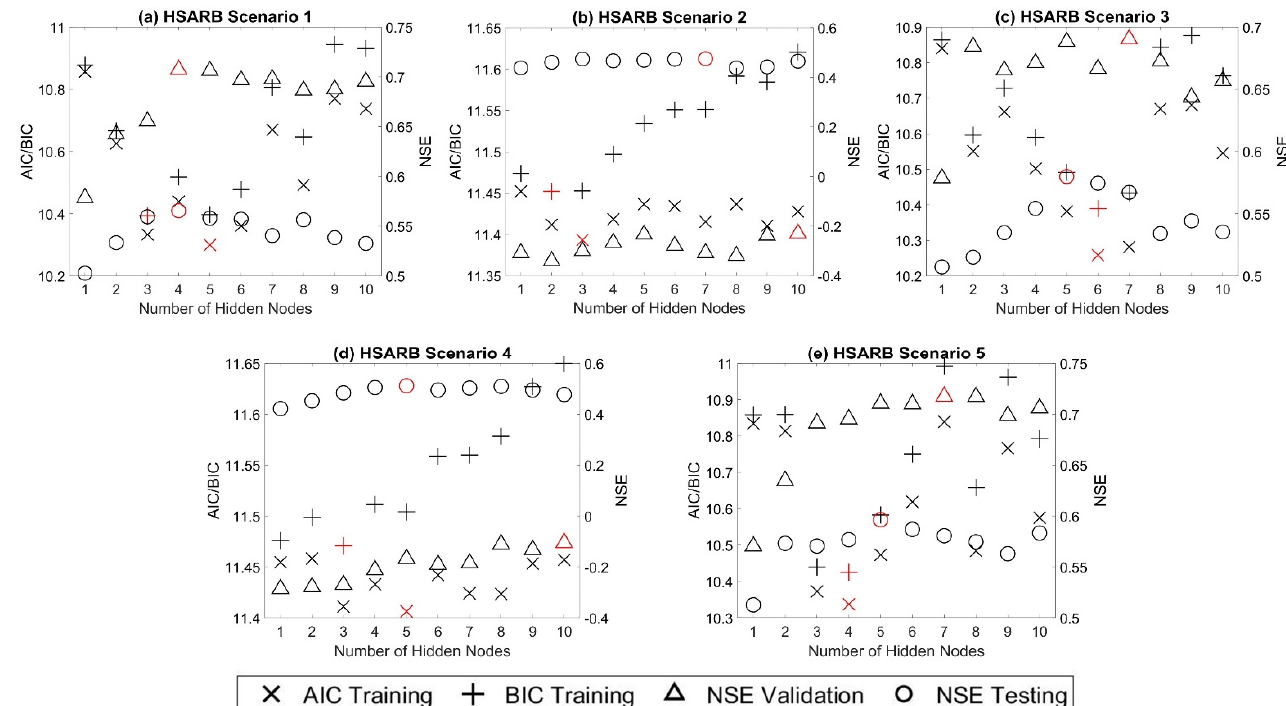
Figure 3. Model statistical performance of prediction scenarios 1 through 5 for the HSARB watershed ( a − e ). The best per- formance measures of each scenario (i.e., the smallest AIC and BIC, the largest NSE) are highlighted in red.